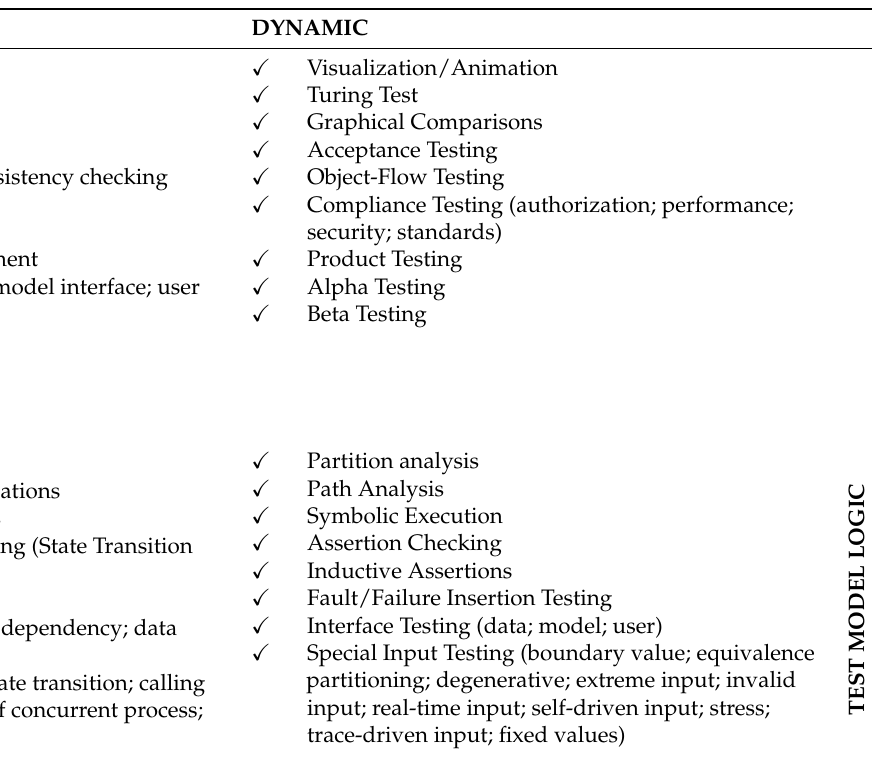
Table 2. Classification of different validation tests, depending on their